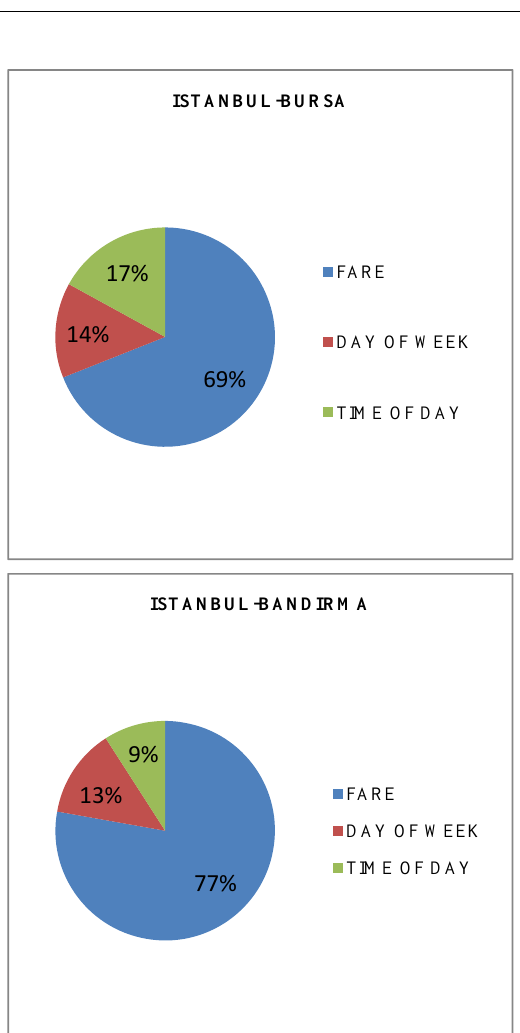
Fig. 2. The importances of attributes for the two ferry